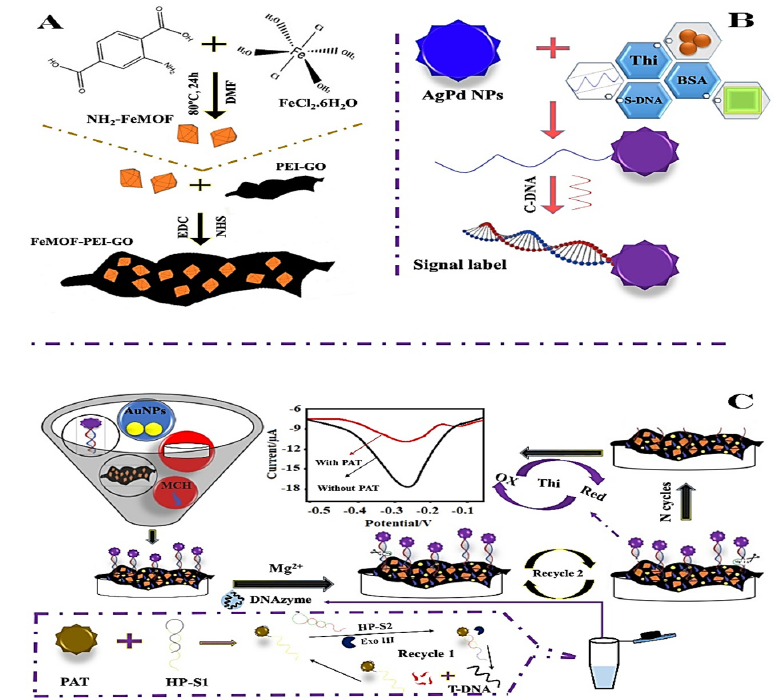
Figure 1. ( A ) Graphical representation of FeMOF-PEI-GO and NH 2 -FeMOF synthesis: ( B ) Nanoprobe fabrication; ( C ) Schematic representation of electrochemical aptasensor and patulin (PAT) detection. Adapted with permission from the article of [58]. 2022, Elsevier.